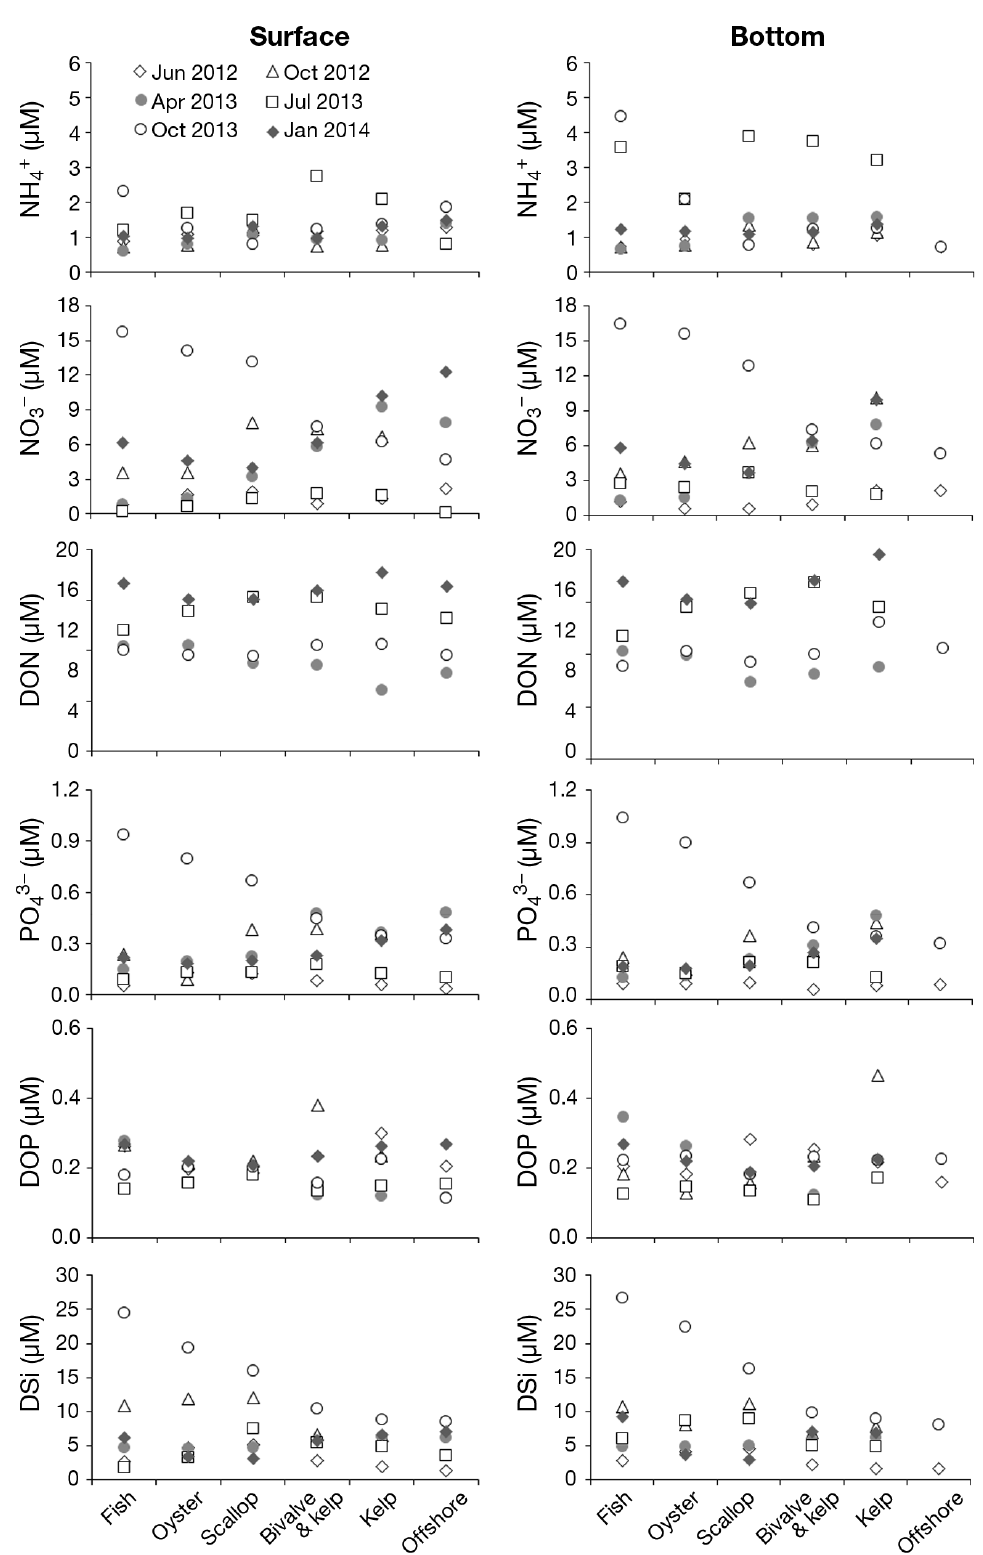
Fig. 6. Nutrient cycles, averaged for various aquaculture regions in Sanggou Bay Left: nutrients in surface water, right: nutrients in the near-bottom layer. DON: dissolved organic nitrogen, DOP: dissolved organic phosphorus, DSi: dissolved